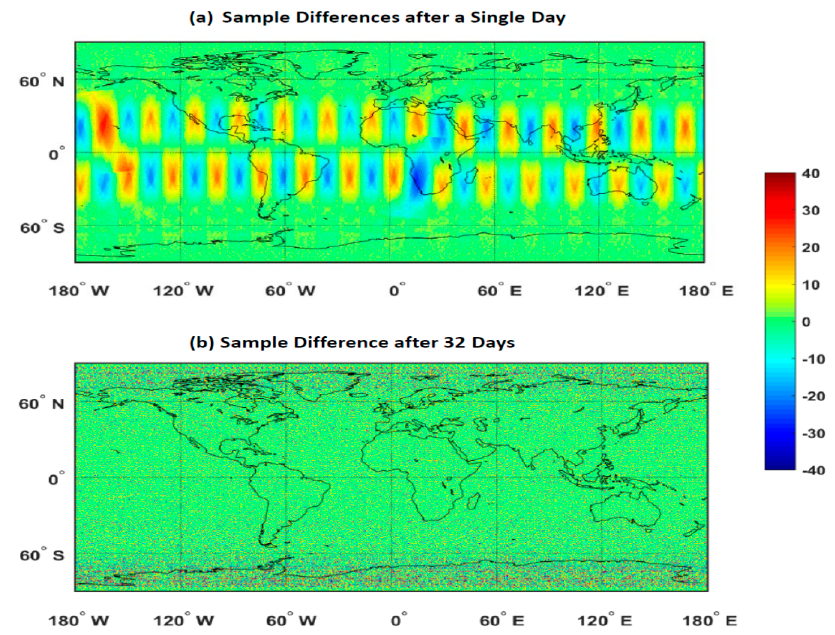
Figure 2. Global distribution of the differences between M (for NOAA-20) and N (for SNPP ) CrIS measurement sample sizes over each location ( i , j ) after one day and 32 days, respectively: ( a ) One day. ( b ) 32 days.